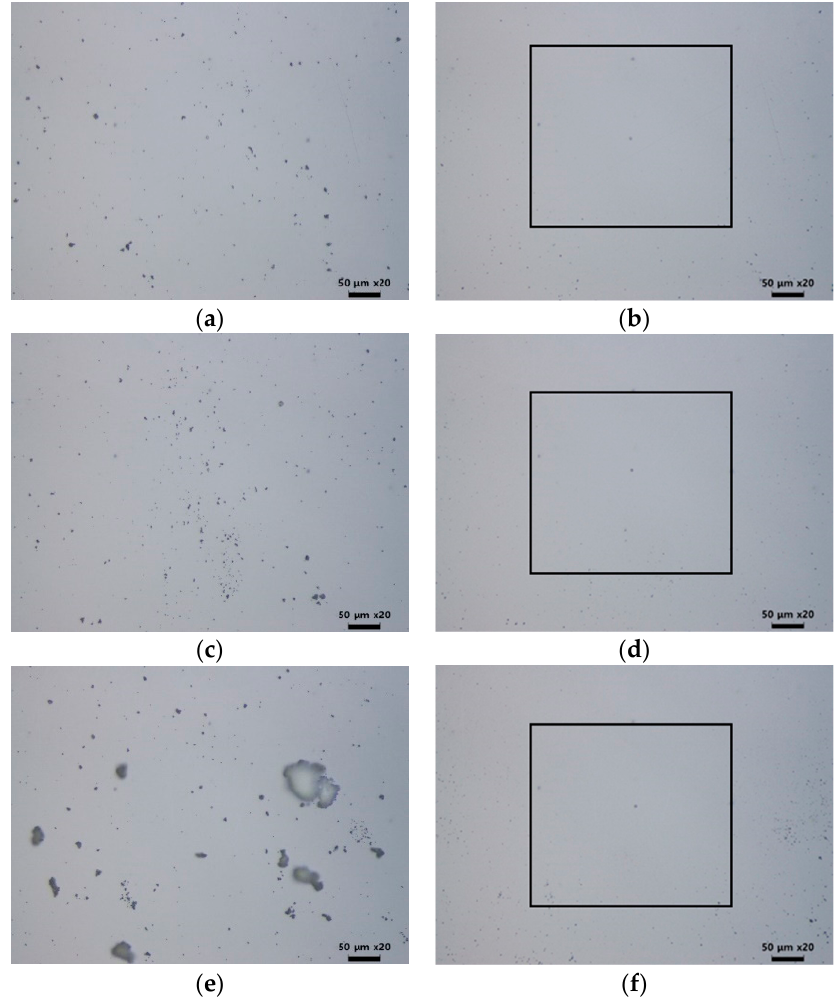
Figure 12. Comparison of laser cleaning efficiency with respect to particle density and distribution ( a ) before cleaning when the particle occupancy rate is 0.4%; ( b ) photo after cleaning of ( a ); ( c ) before cleaning when particle occupancy rate is 0.8%; ( d ) after cleaning of ( c ); ( e ) before cleaning when particle occupancy rate is 6%; ( f ) after cleaning of ( e ).